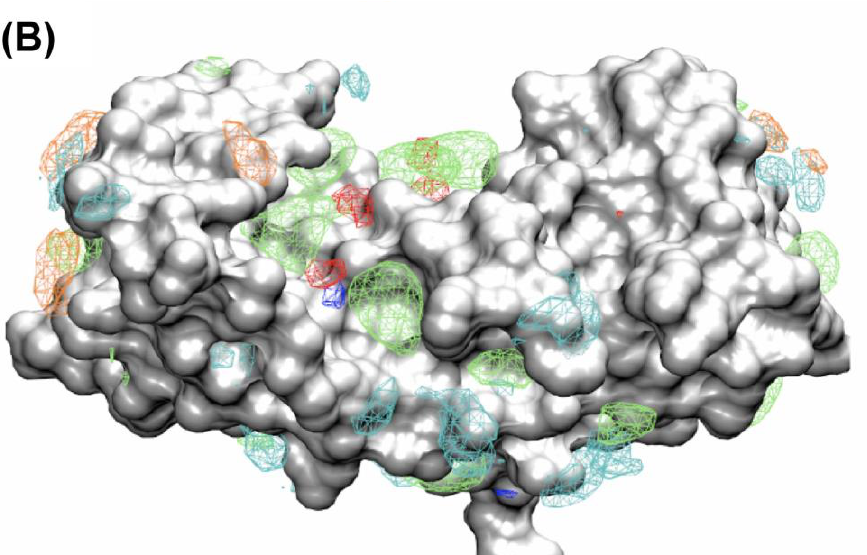
Figure 6. SILCS FragMaps of S100B and S100A1. SILCS FragMaps for ( A ) Ca 2+ -S100B and ( B ) Ca 2+ -S100A1. Maps are rendered at GFE level of −1.2 kcal/mol for Apolar (green), hydrogen bonding donor (blue) and acceptor (red) maps and at −1.5 kcal/mol for positively charged MAMN (cyan) and negatively charged ACEO (orange) maps. For S100B, Sites 1, 2 and 3 are shown in dashed circles in green, yellow, and copper, respectively [16]. The S100B inhibitor from the crystal structure 4PE0, which is located within the Site 2, is shown in ( A ) as a cyan stick